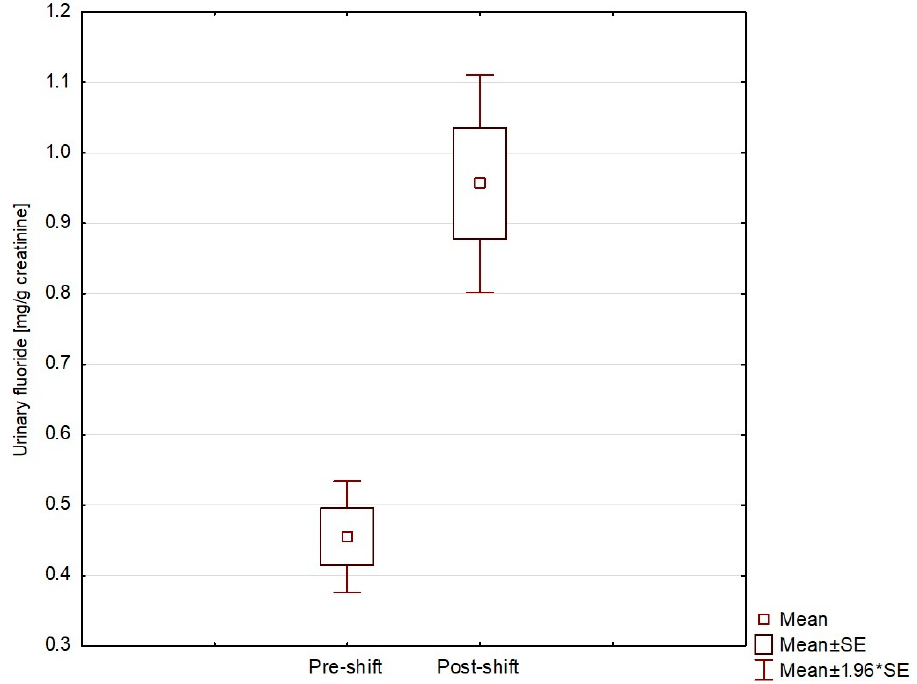
Figure 4. Comparison of pre-shift and post-shift urinary fluoride concentration for all participants. According to Wilcoxon signed-rank test, mean post-shift urinary fluoride concentration was significantly ( p < 0.001) higher compared to mean pre-shift urinary fluoride concentration for all investigated participants. From this, it can be concluded that there is an